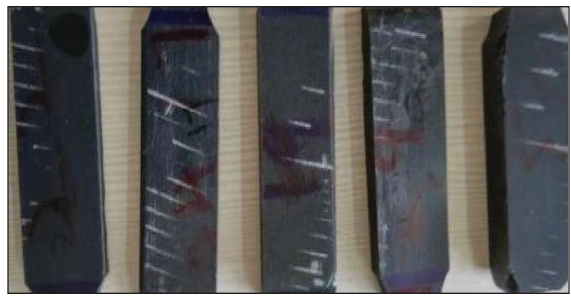
Figure 8: Hardness